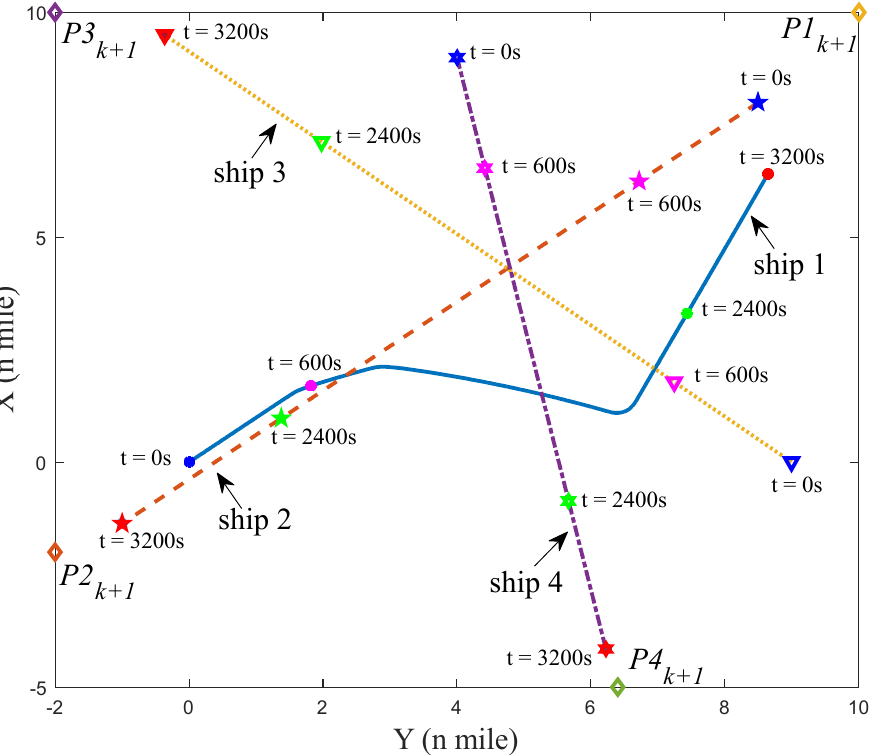
Figure 21. The situation of four ships at t = 3200 s in scenario 3.